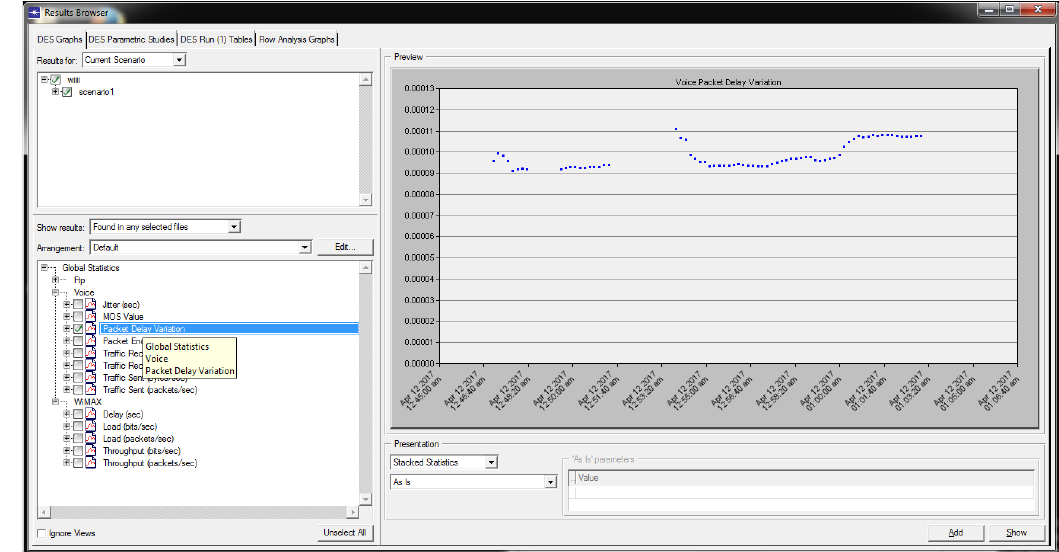
Fig. 8. Global Statistics WiMax packet delay variation for overall network, reaches 0.00011 second for maximum and 0.00902 second for minimum.